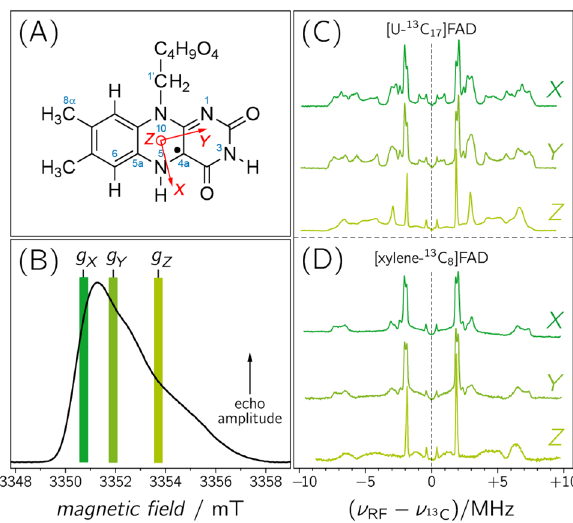
Figure 1. ( A ) IUPAC numbering of riboflavin (including the principal axes of the g -matrix). ( B ) Pulsed EPR spectrum of photolyase recorded with a microwave frequency of 94.0 GHz at a temperature of 80 K. The magnetic-field positions of the three principal values of the g -matrix ( g X = 2.00429(2), g Y = 2.00359(2), and g Z = 2.00218(2)), at which ENDOR spectra were recorded (dark green at g X , medium green at g Y and light green at